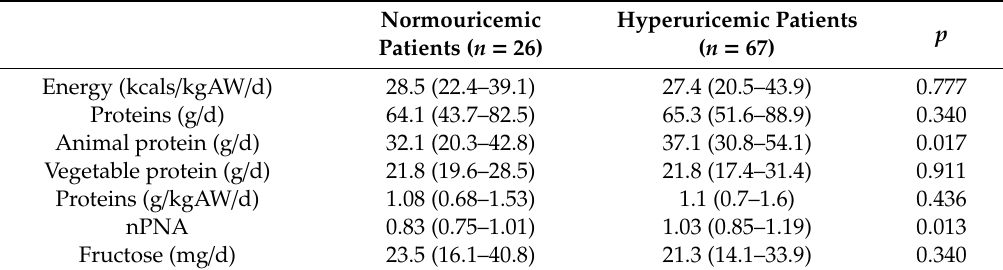
Table 5. Association between uric acid and nutritional status for albumin ≥ 3.5 g/dL in hemodialysis patients.